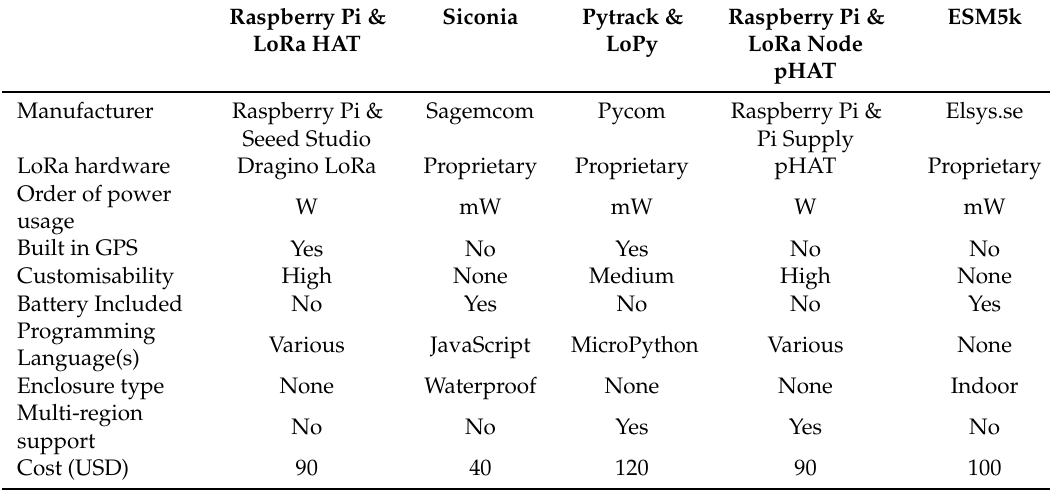
Table 2. Comparison of different LoRaWAN nodes. Prices correct as of December 2019; price is for working hardware excluding a power supply, when not included.